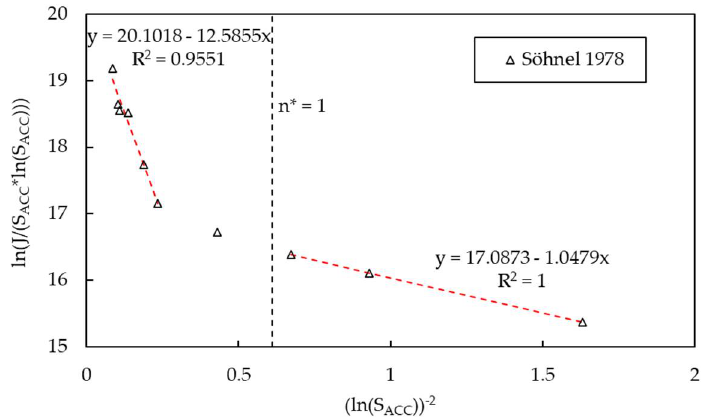
Figure 9. Linearized nucleation data of amorphous calcium carbonate (ACC) assuming diffusion limitation. The data show two linear relations which can be attributed to two separate calcium carbonate nucleation morphologies. The dashed line indicates where the classical nucleation theory predicts a critical nucleus size of one molecule for the first ACC polymorph. This indicates a shift of the solubility constant towards a different polymorph can be expected.